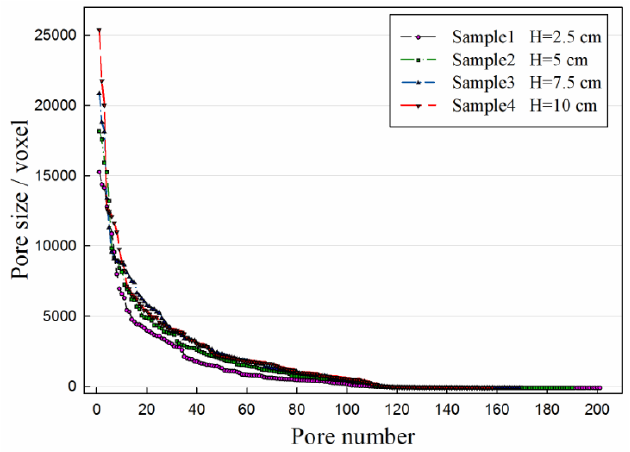
Figure 8. The pore volume curve vs. sample height in the bed.